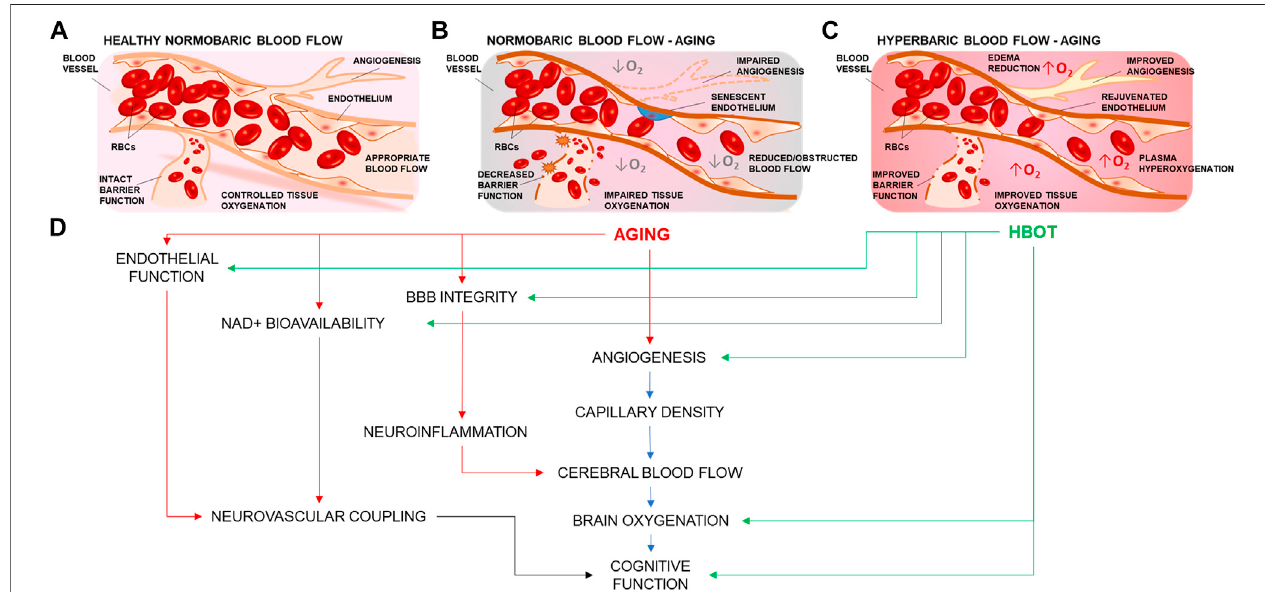
FIGURE 1 | Summary representation of the cerebrovascular effects of hyperbaric oxygen treatment. (A) Representation of a branching cerebral arteriole. In young healthy individuals, inhaled 21% O 2 is suf fi cient to ensure adequate brain oxygenation. (B) Age-related cerebromicrovascular disease is associated with increased BBB permeability, neuroin fl ammation, declining endothelial function, mitochondrial dysfunction, oxidative stress, loss of Nrf2 activity, increase in senescent cell burden, and NAD+ depletion (C) Administration of 100 percent oxygen in a pressurized environment results in hemoglobin saturation and hyperoxygenated plasma Hyperoxygenation exerts multiple bene fi cial effects that ameliorate and reverse brain microvascular pathologies. (D) HBOTtargetsmany of the age-related impairments in vascular mechanisms that drive regulation of blood fl ow and cognition.